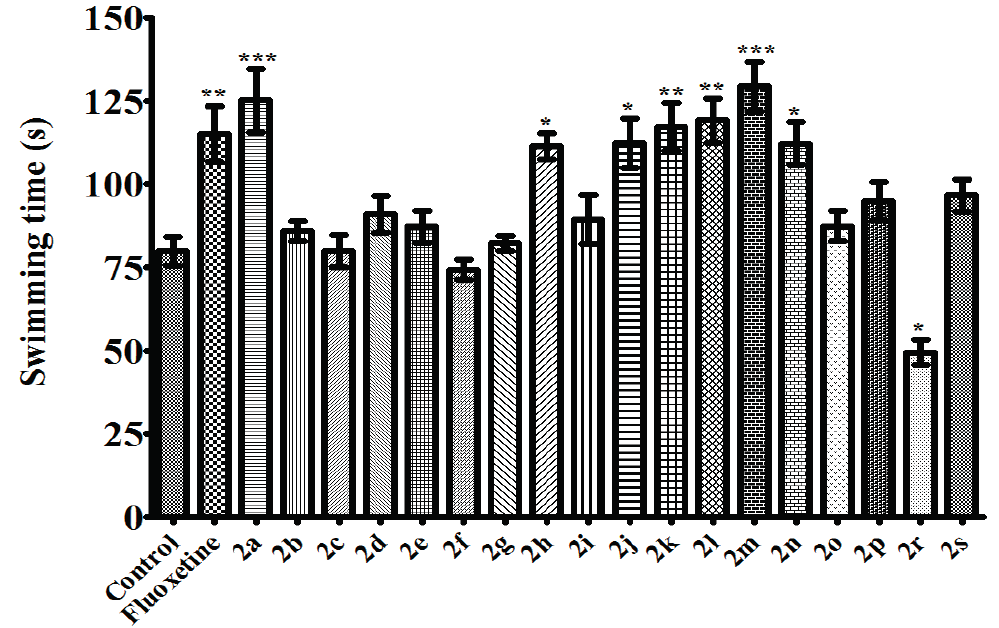
Figure 3. Effects of test compounds (100 mg/kg) and fluoxetine (10 mg/kg) on swimming time of mice in MFST. Significance against control values * p < 0.05, ** p < 0.01, *** p < 0.001. Values are given as mean ± SEM. One-way ANOVA, post-hoc Tukey’s test, n =